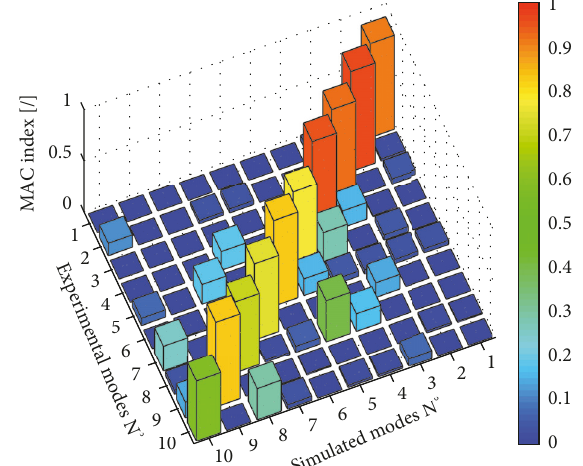
Figure 12: MAC coefficient for the door test, after geometry refine- ment.